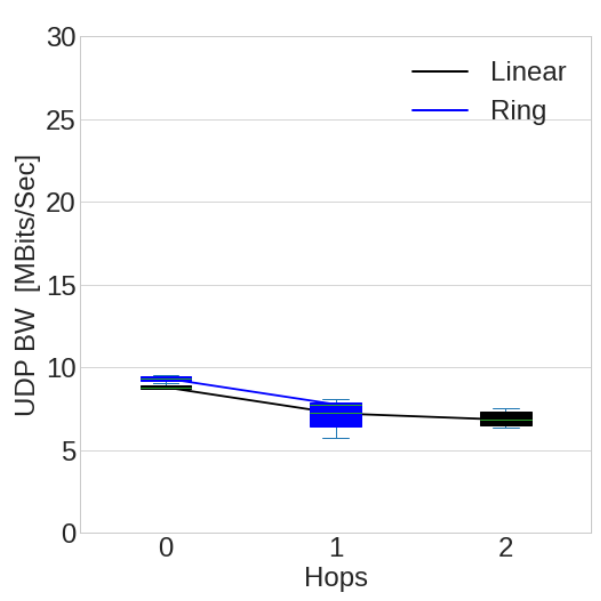
Figure 14. POWDER lab UDP